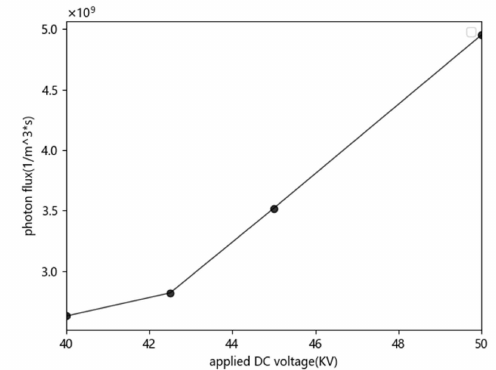
Figure 10. Variation of luminous flux with applied DC voltage.